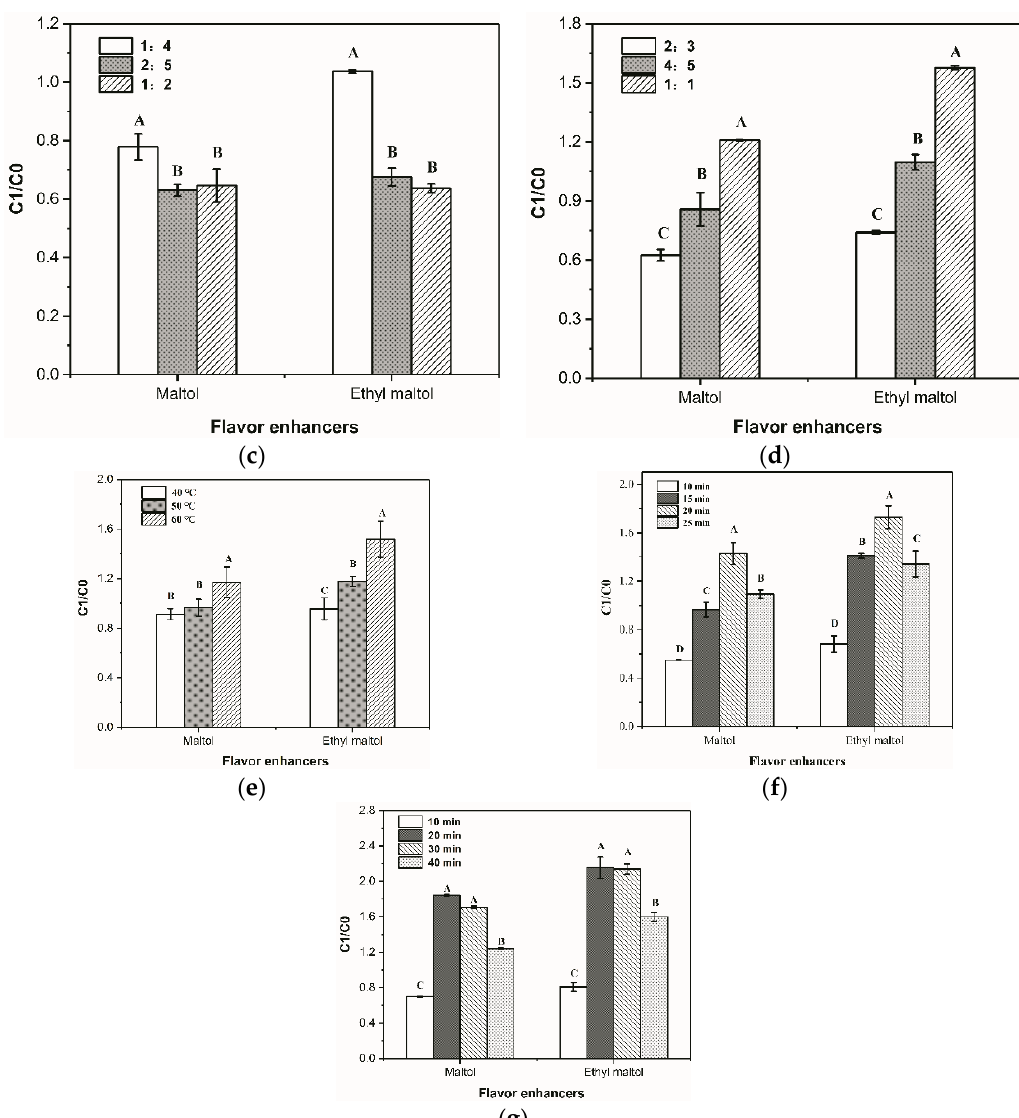
Figure 1. Optimization of conditions for pretreatment dispersive liquid-liquid microextrac- tion/headspace solid-phase microextraction (DLLME/HS-SPME): ( a ) Different types of extractants (dichloromethane, chloroform, and carbon disulfide); ( b ) different types of dispersants (methanol, acetonitrile, and acetone); ( c ) different extractant volume to dispersant volume ratios; ( d ) different aqueous volume to total volume of dispersant and extractant; ( e ) different incubation temperatures (40 °C, 50 °C, and 60 °C); ( f ) different incubation times (10 min, 15 min, 20 min, and 25 min); ( g ) different extraction times (10 min, 20 min, 30 min, and 40 min), on the extraction efficiency of flavor enhancers. Note: C1/C0, the peak area of flavor enhancers (maltol and ethyl maltol)/the peak area of cyclohexanone standard. The superscript letters (A-D) in each histogram indicate significant dif- ferences ( p < 0.05) for the samples.